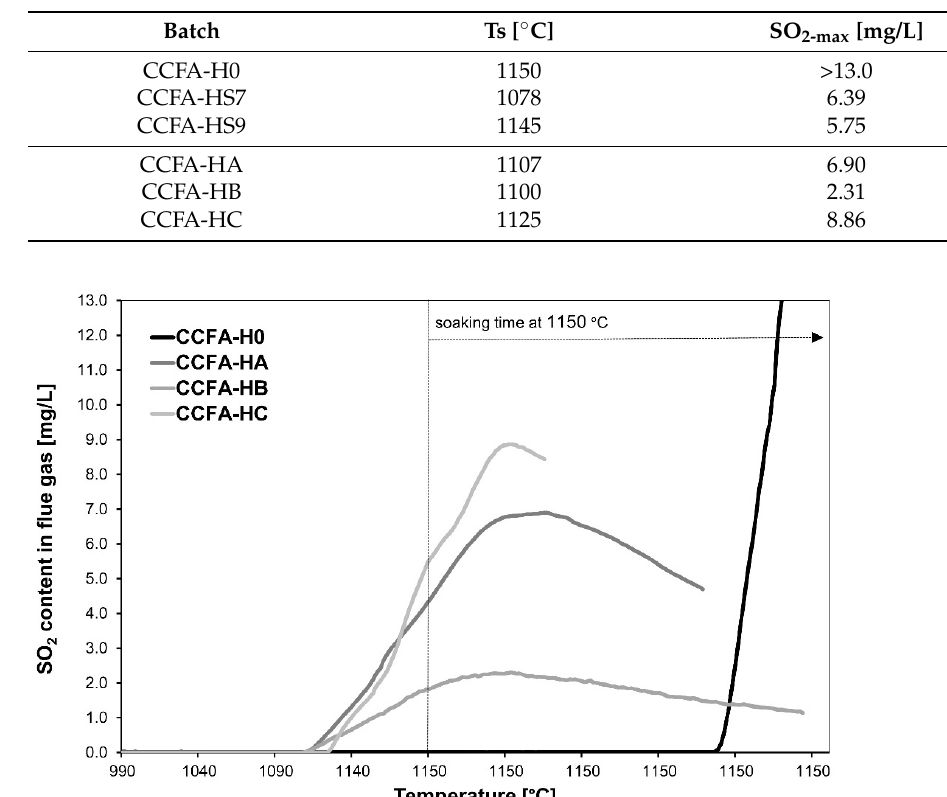
Figure 8. The content of SO 2 in the flue gas during the firing of CCFA dry-pressed bodies—the effect of different ratios of sodium carbonate and sodium water glass. of different ratios of sodium carbonate and sodium water